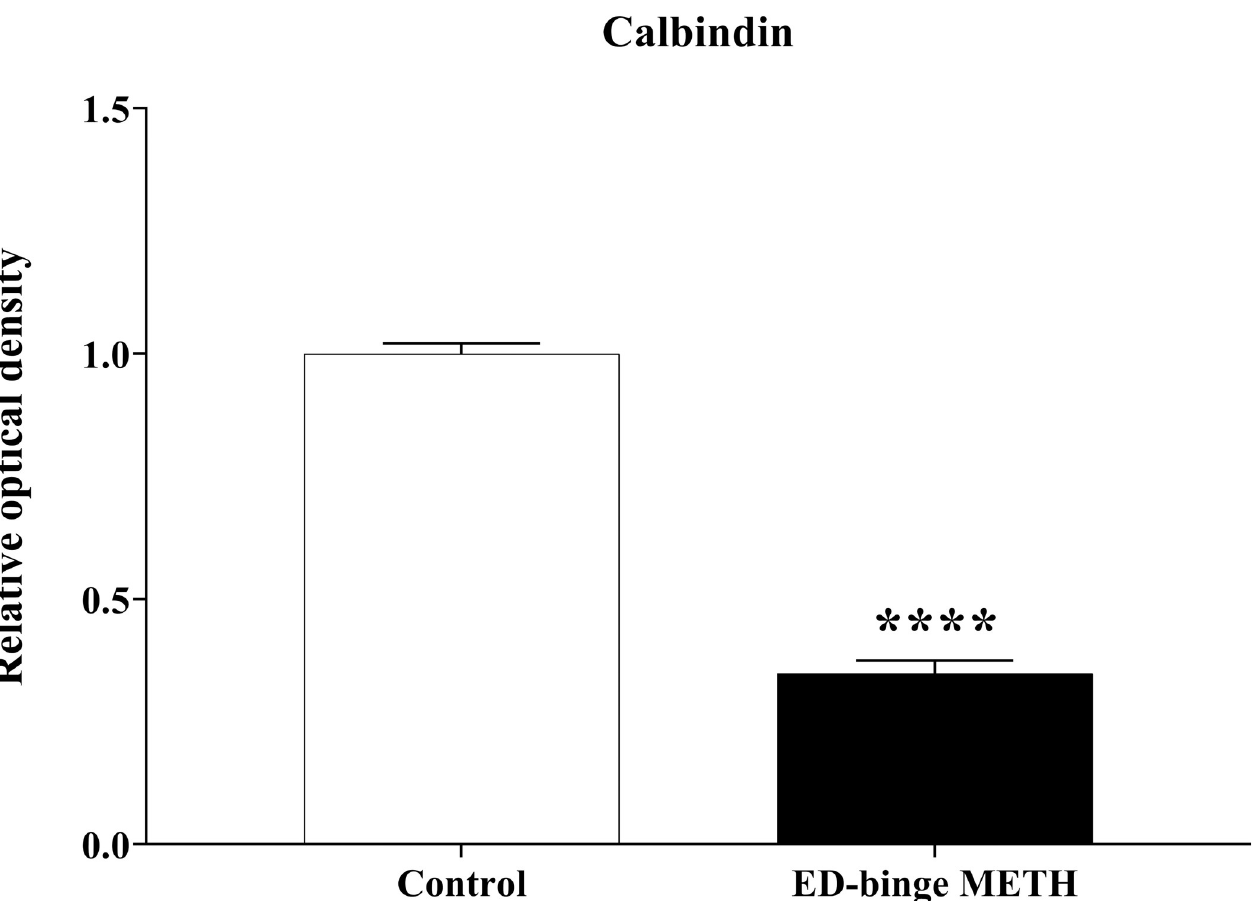
Fig 10. Relative optical density of calbindin expression levels in rat sperm (METH vs. control). Values are shown as mean ± SEM, n = 5 per group ( ���� P < 0.0001; unpaired Student’s t test).